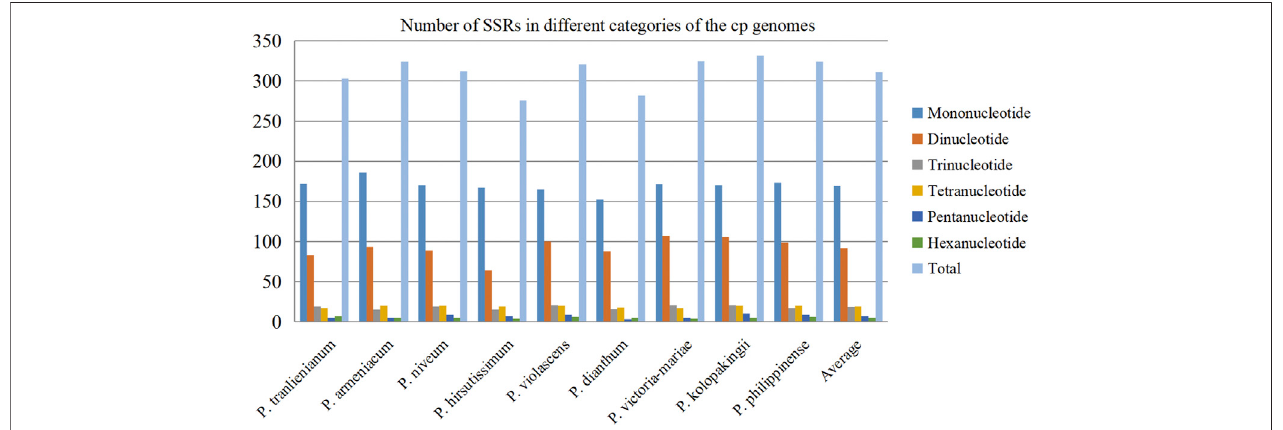
FIGURE 3 | Distribution of different categories of simple sequence repeats (SSRs) in the nine cp genomes.